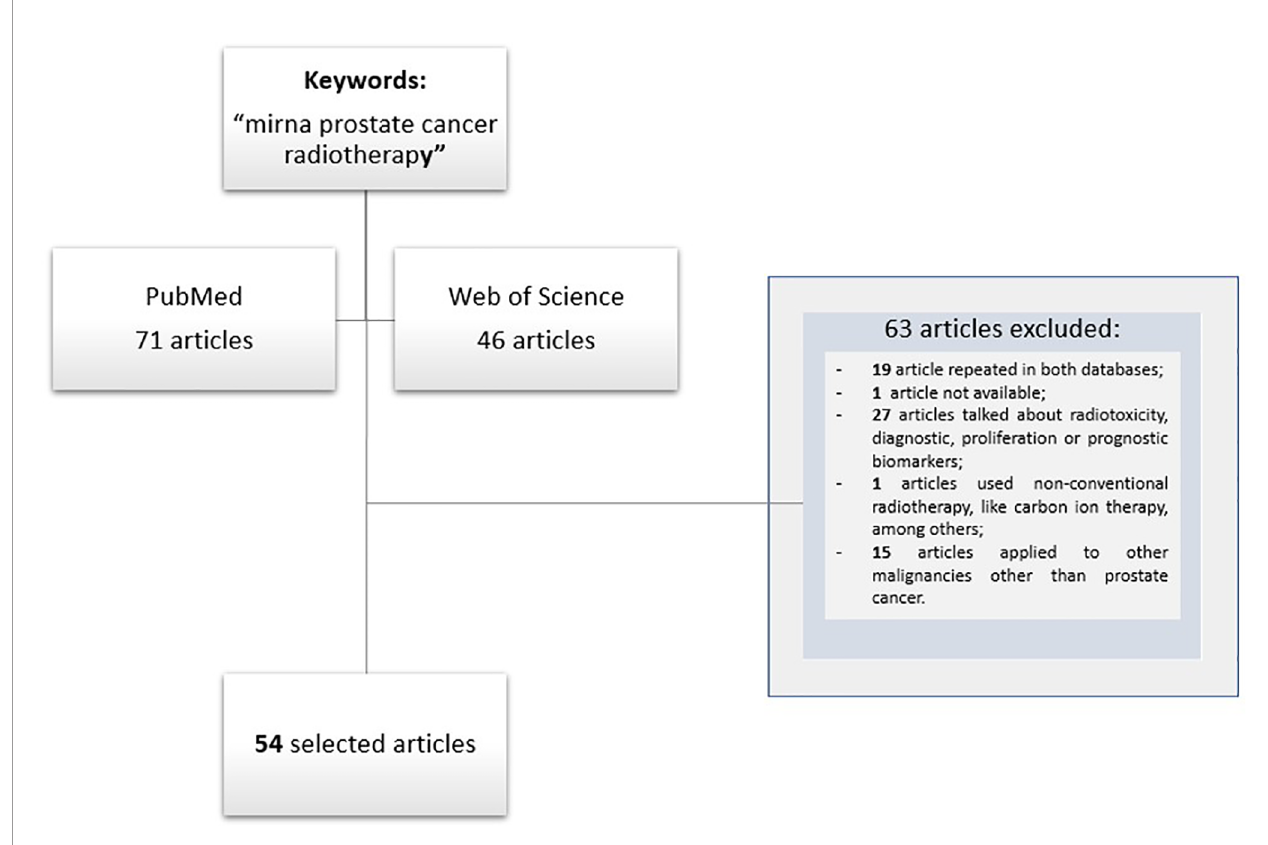
FIGURE 1 | Flow diagram of studies